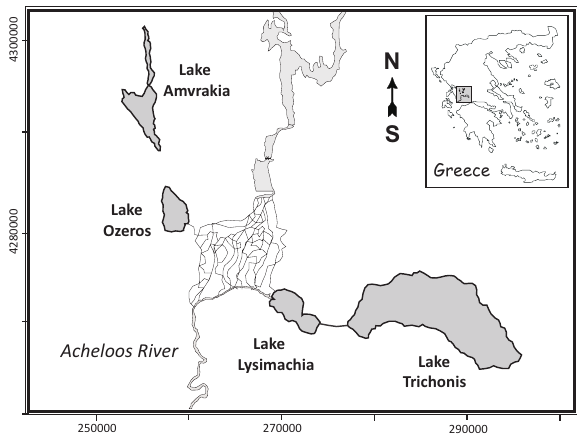
Figure 1. Geographic location of the three lakes, Trichonis, Oz- eros, and